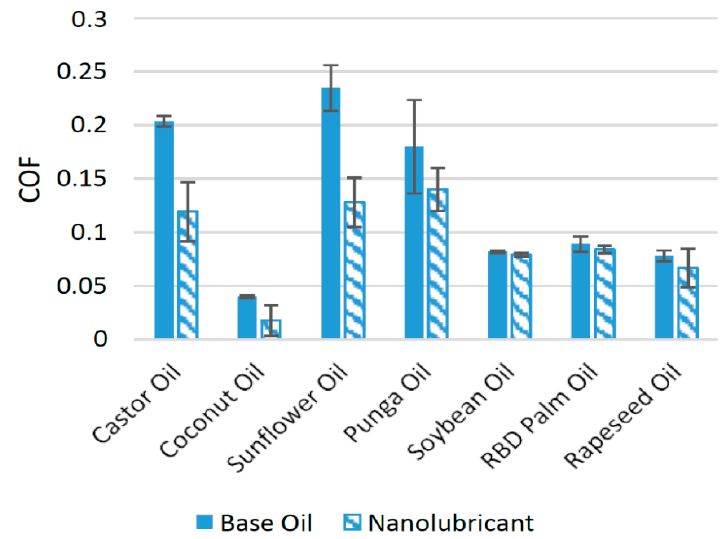
Figure 18. Effect of CuO NPs on the friction performance of bio-lubricants.